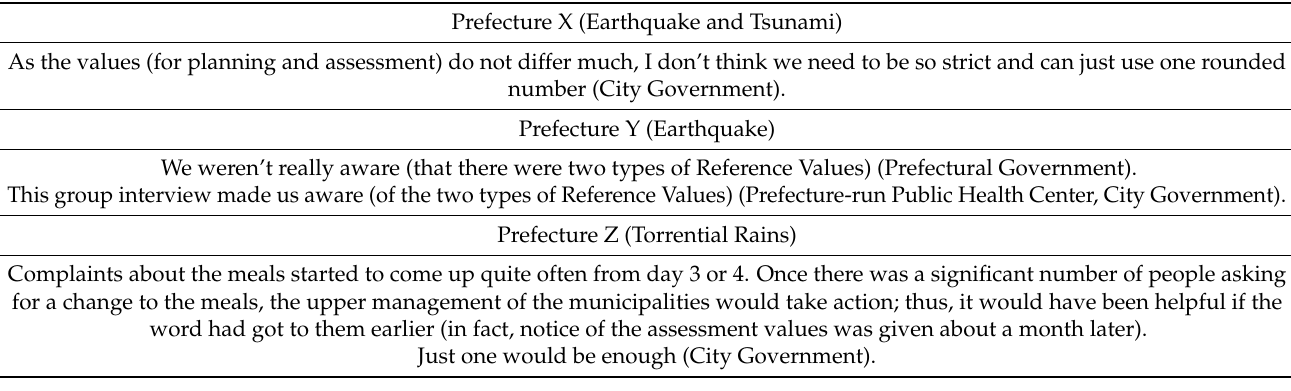
Table 4. Were the Reference Values for meal planning and assessment used separately?